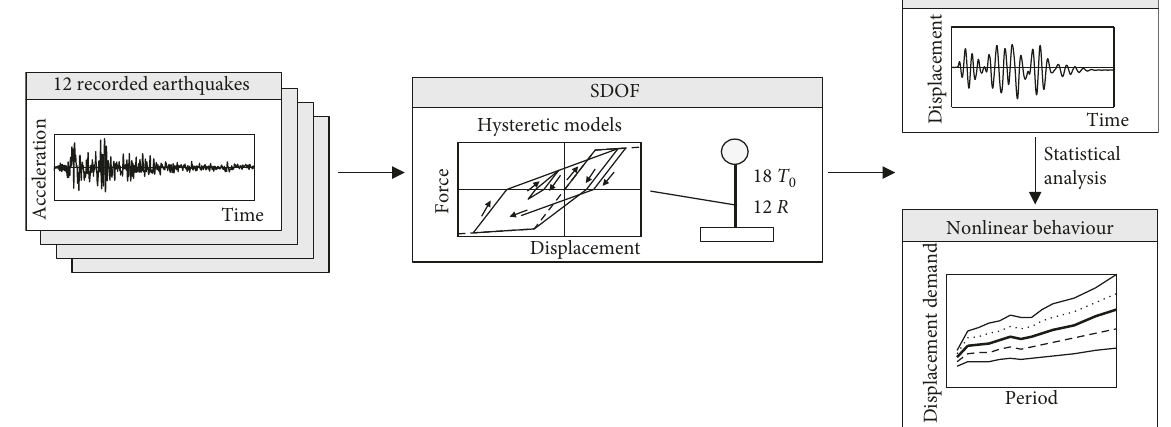
Figure 7: Schematic description of the methodology used for the